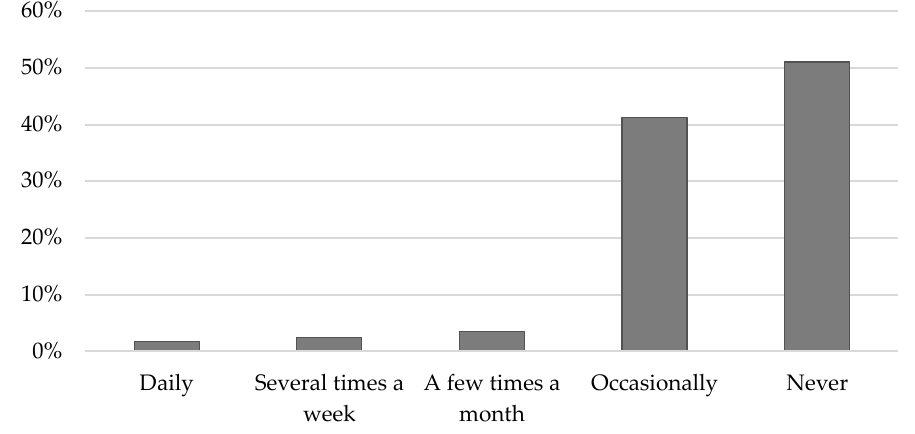
Figure 16. Public transport frequency in the RMSC.